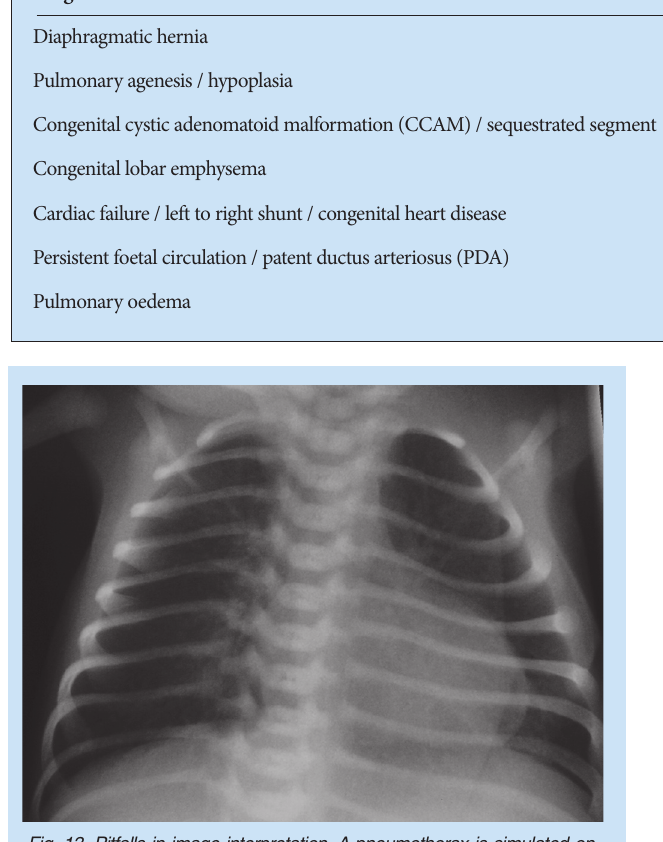
Fig. 13. Pitfalls in image interpretation. A pneumothorax is simulated on the left by skin folds. These are distinguished by the fact that they extend beyond the limits of the chest and because lung markings are present lateral to the ‘edge’.